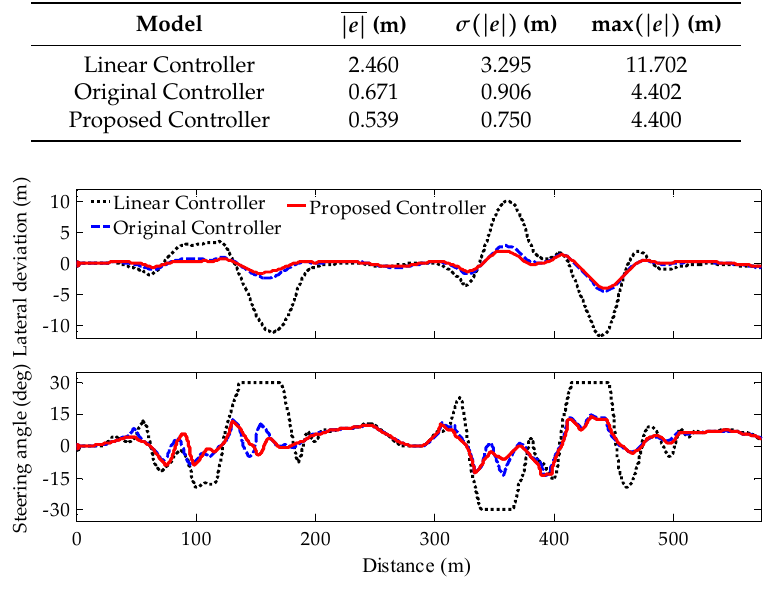
Figure 11. The simulation results of lateral deviation and steering angle of different controllers.